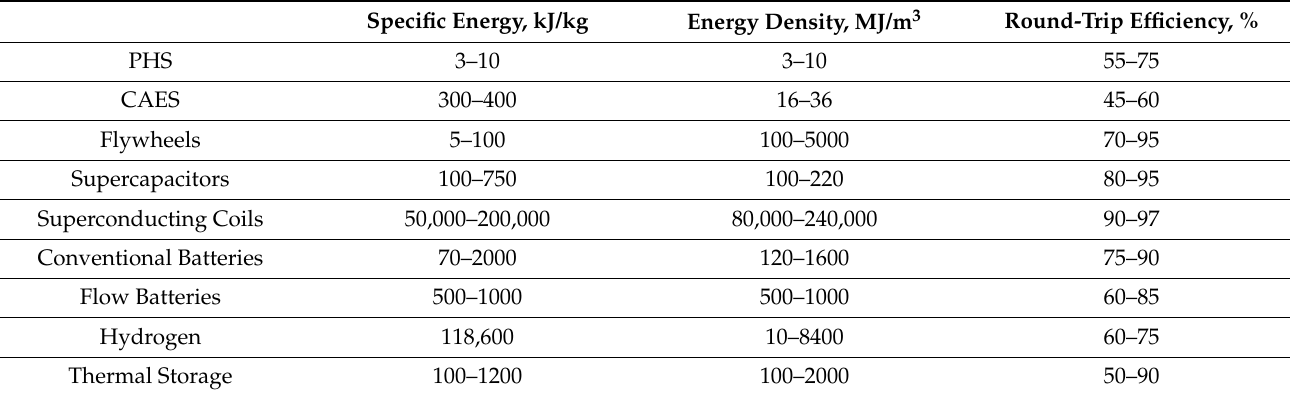
Table 6. Thermodynamic properties and round-trip efficiencies of ES